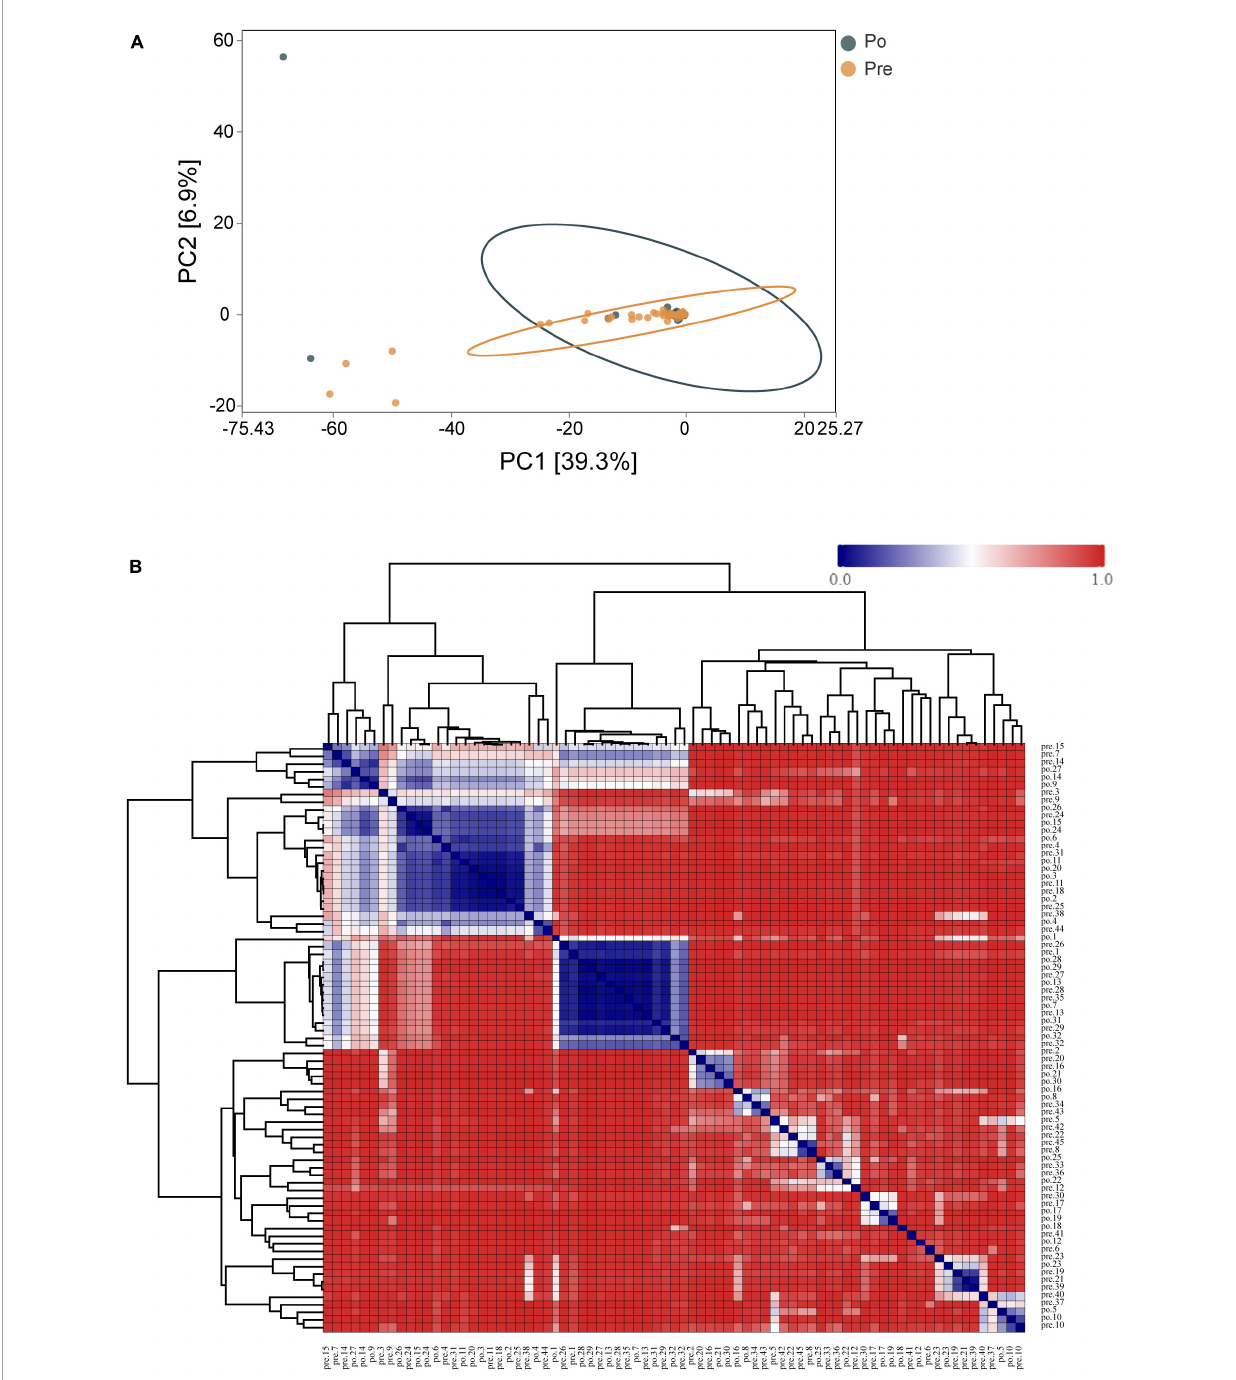
FIGURE3 Distribution of the vaginal microbiota in all the samples. PCA was applied to demonstrate the distribution of the vaginal microbial communities in the samples (A) . Each symbol represents a sample (dark green, Po; brown, Pre); the variance explained by the PCs is indicated in parentheses on the axes. Heatmap based on the hierarchical clustering solution (Bray–Curtis’s distance metric of the 77samples) (B) . Rows and columns represent the 77 samples. The lower number represents more remarkable similarity in bacterial microbiota between samples in the heatmap. Note: the pre-operative group (Pre); post-operative group